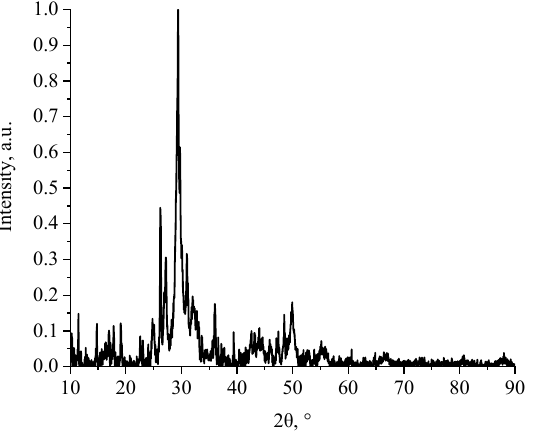
Figure 4. X-ray diffraction pattern of calcium silicate obtained from calcium acetate. Analysis of the diffraction pattern of the calcium silicate obtained from calcium ace- tate showed that high-intensity bands were obtained in the sample at 2 θ = 26.21, 29.38, and 49.92°, which corresponded to the crystalline phase of wollastonite. In contrast, the use of calcium chloride and calcium nitrate as calcium-containing precursors was accom- panied by amorphization of the CaSiO 3 structure. The results obtained were consistent with other works [41–43]. In the next stage of the work, a study was carried out to determine the effect of the type of amino acid on the microstructure of the calcium silicate nanoparticles. The samples were examined using SEM microscopy. The results are shown in Figure 5 and the Supple- mentary Materials. ( a )